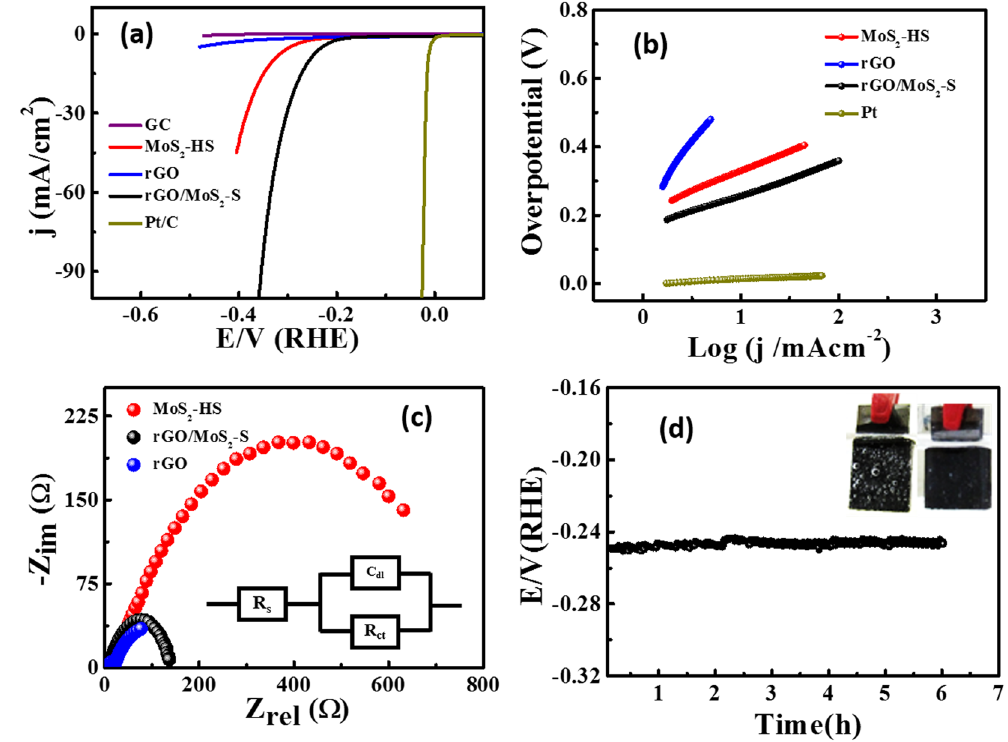
Figure 8. ( a ) Linear sweep voltammograms (LSV) of bare GC, Pt/C, MoS 2 -HS, rGO and rGO/MoS 2 -S hybrid modified electrodes towards HER in 1 M H 2 SO 4 at a sweep rate of 5 mV/s, ( b ) Corresponding Tafel plots, ( c ) Nyquist plots of MoS 2 -HS, rGO and rGO/MoS 2 -S hybrid modified electrodes. ( d ) The long-term stability of